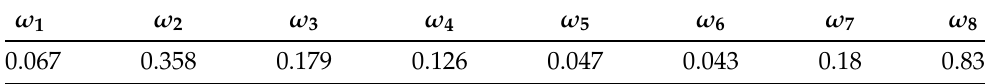
Table 3. Weights